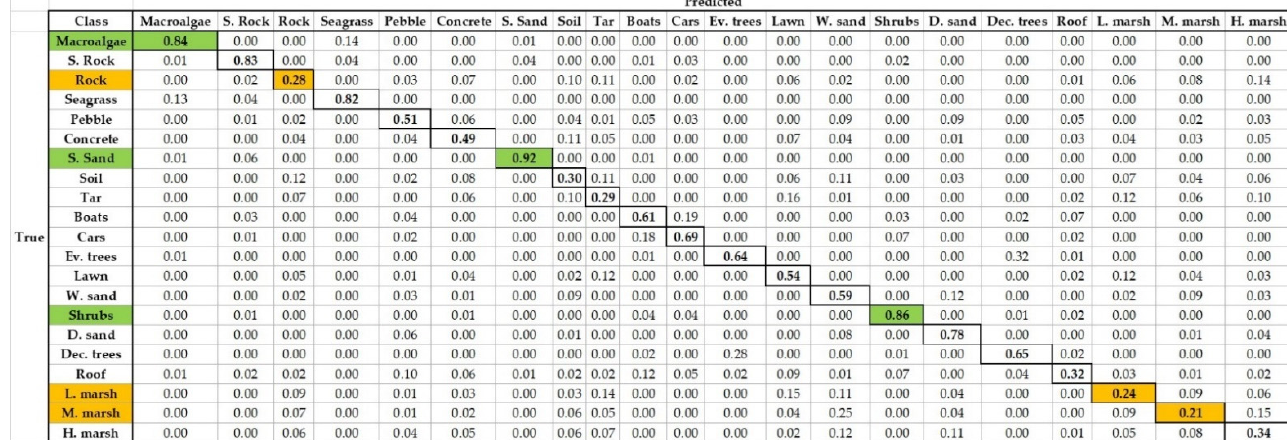
Figure A5. Difference of the confusion matrixes obtained for the classification of green waveforms’ features plus infrared intensities, and green waveforms’ features only. The three highest and three lowest class accuracy values are highlighted in green and orange, respectively. S. = submerged, Ev. = evergreen, Dec. = deciduous.